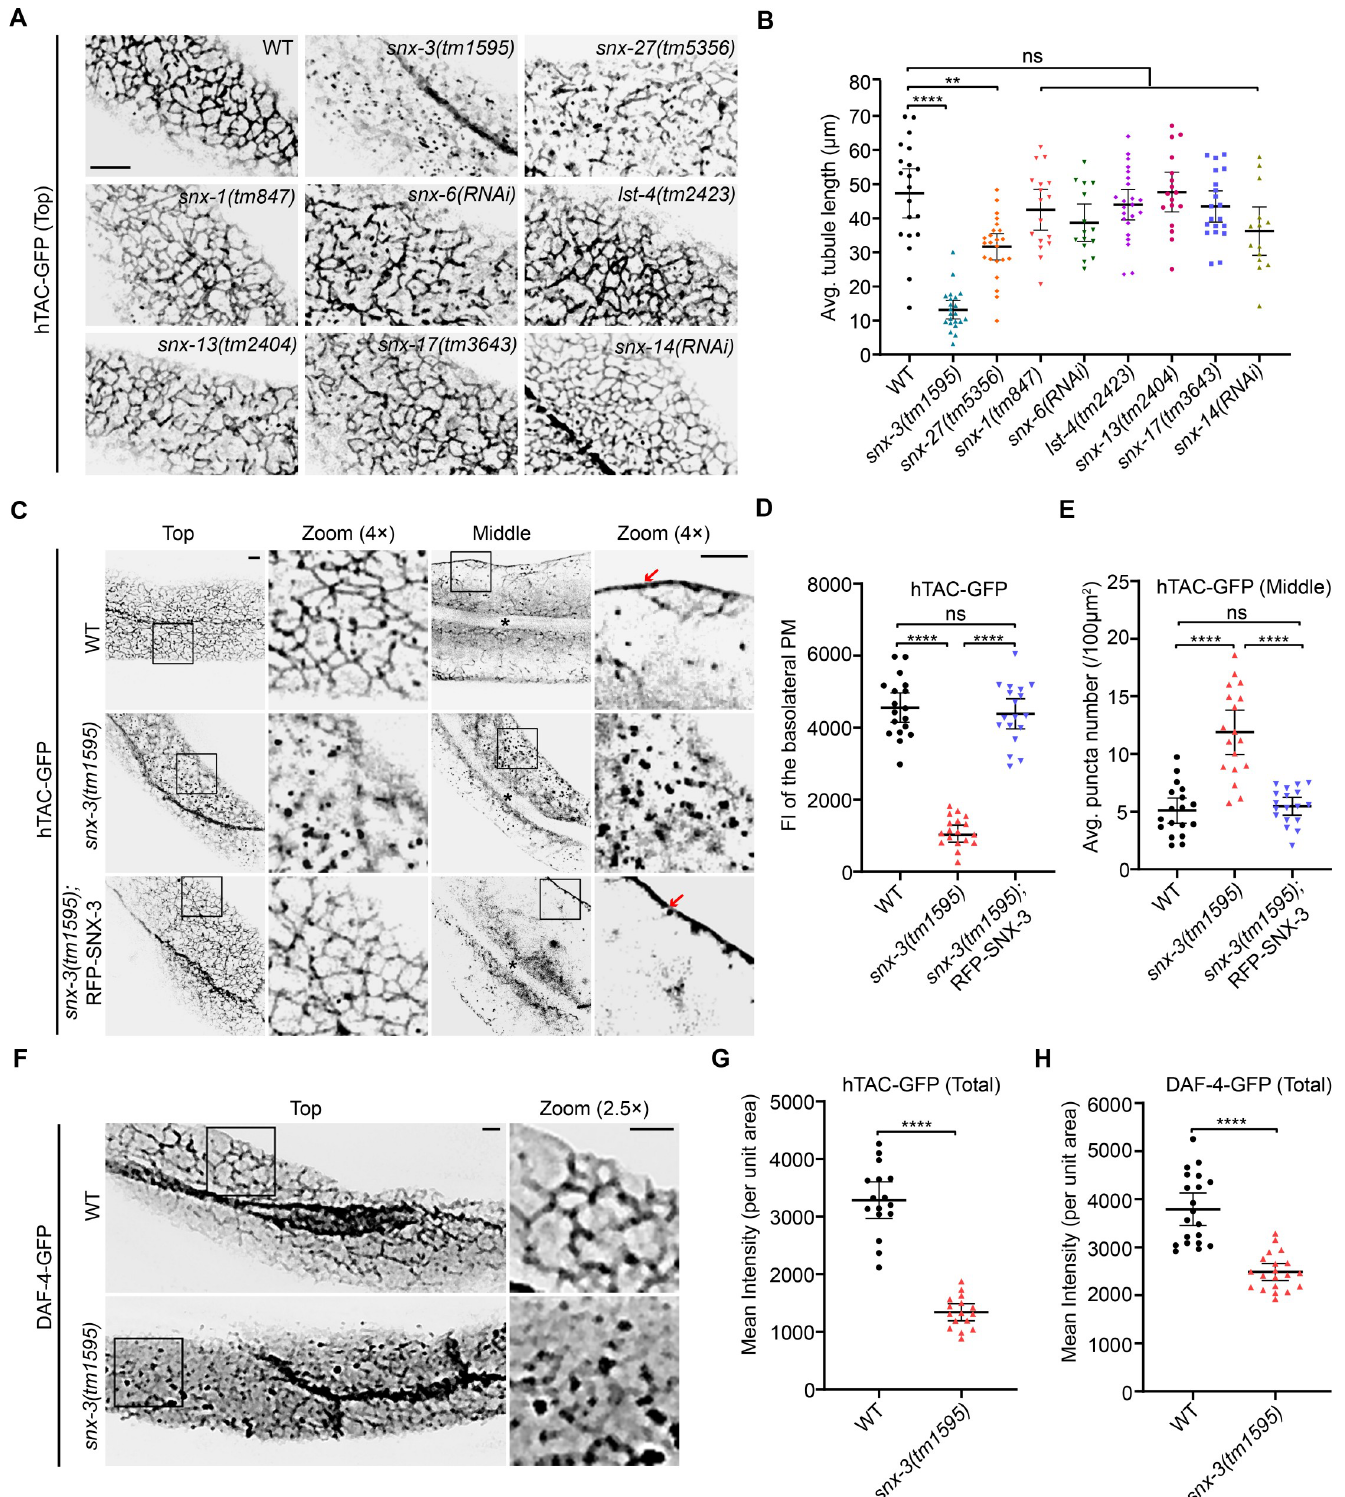
Fig 1. C . elegans SNX-3 is required for formation of clathrin-independent recycling endosomal tubules. (A) Confocal images provide the effect of various SNX mutant or RNAi treatment on the subplasmalemmal hTAC-GFP-containing tubular endosomes. (B) The average length of hTAC-positive tubules per 100 μ m 2 was calculated for intestines of each indicated genotype. Error bars are mean ± 95% CI ([ROI] = 20/22/23/17/15/23/17/20/14, n = 20/22/23/17/15/23/17/20/14 for WT/ snx-